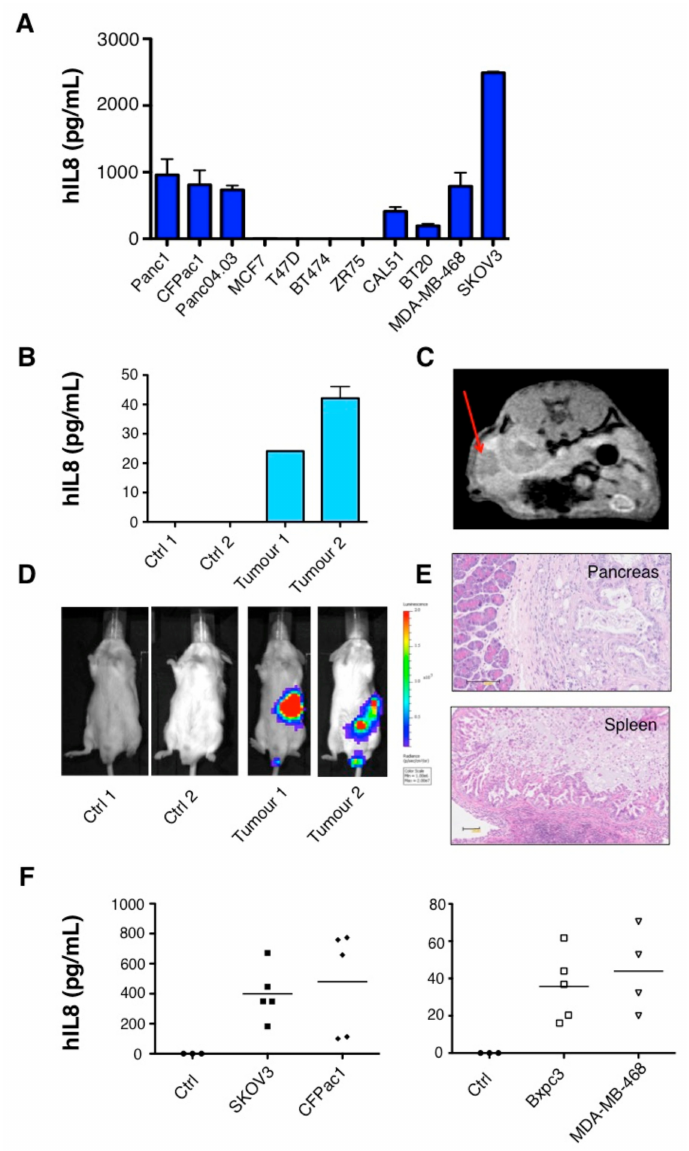
Figure 1. Detection of Interleukin-8 (IL-8) in the supernatant of cancer cell lines and in the circulation of mice with solid tumor xenografts. ( A ) Supernatant was collected from pancreatic, luminal, and triple negative breast or ovarian cancer cell lines 48 h after seeding 5 × 10 5 cells in a 6-well plate. Data show the mean ± standard error of the mean (SEM) of IL-8 measured using enzyme-linked immunosorbent assay (ELISA) in 3–4 independent experiments. ( B ) Plasma levels of human IL-8 in mice bearing orthotopic Panc04.03 pancreatic xenografts as detected by ( C ) magnetic resonance imaging (MRI) and ( D ) bioluminescence imaging (BLI). Red arrow denotes location of tumor in MRI scan in ( C ). Control (Ctrl) mice were tumor-free. ( E ) Orthotopic tumor infiltration of pancreas and spleen was confirmed histologically by H and E staining of tissue. Scale bar: 100 µ M. ( F ) Circulating human IL-8 was detected in the plasma of mice bearing intraperitoneal tumor xenografts of ovarian, pancreatic, and breast origin. Data show the mean and individual data points for each